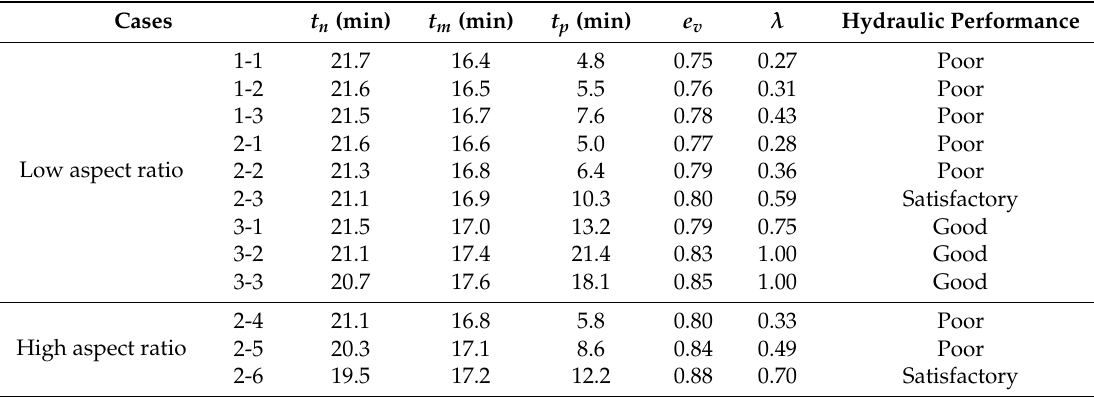
Table 6. Nominal retention time, mean residence time, peak time, effective volume, and hydraulic efficiency of cases with low-density emergent